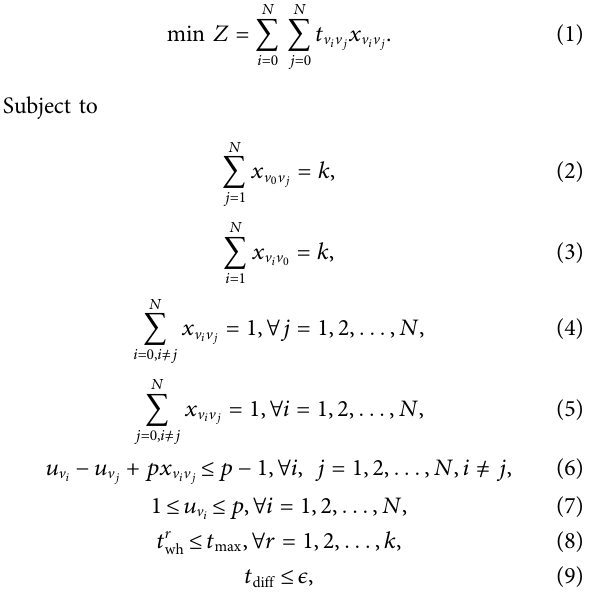
The objective is to balance the working hours of each inspection team and minimize the total working hours, see Figure 1 . The system model can be written by